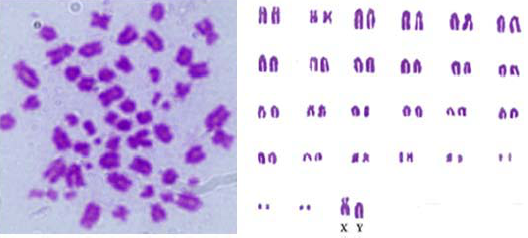
F IGURE 10. Metaphase spread and idiogram of Spermophilus fulvus.